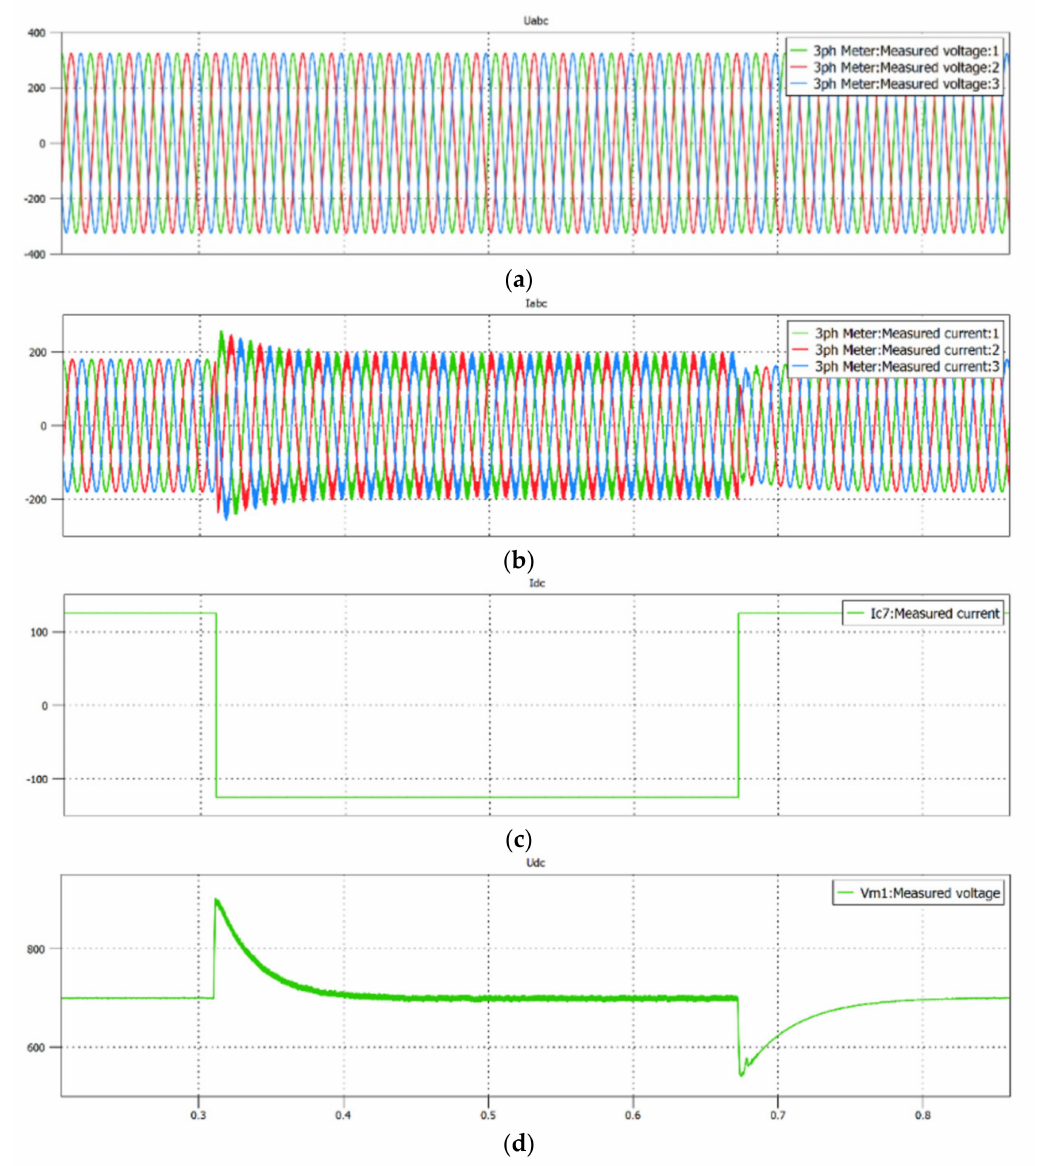
Figure 6. Simulation result—step load changes of AC/DC converter, from 85 kW of active power consumed from the grid, through 85 kW of active power restored to the grid, up to 85 kW consumed from the grid: ( a ) grid voltages; ( b ) grid currents; ( c ) DC-link current; ( d ) DC-link